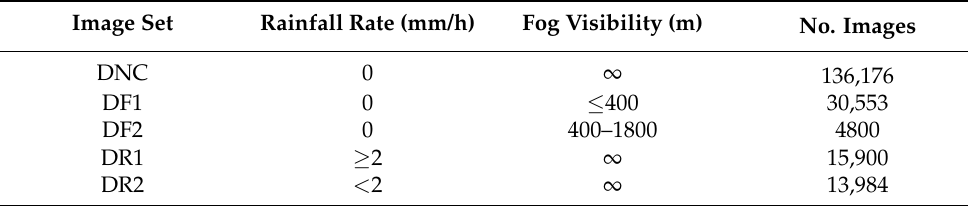
Table 3. Characteristics of the Cerema-AWH